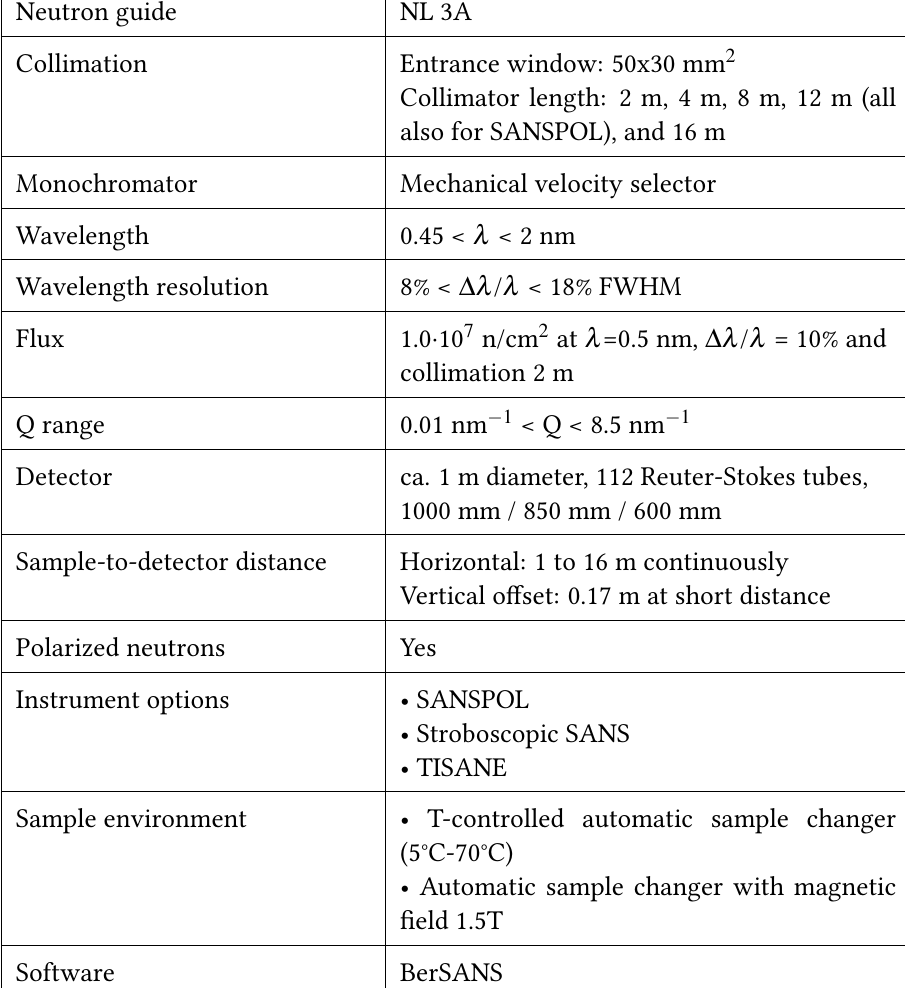
Table 1: Technical parameters of